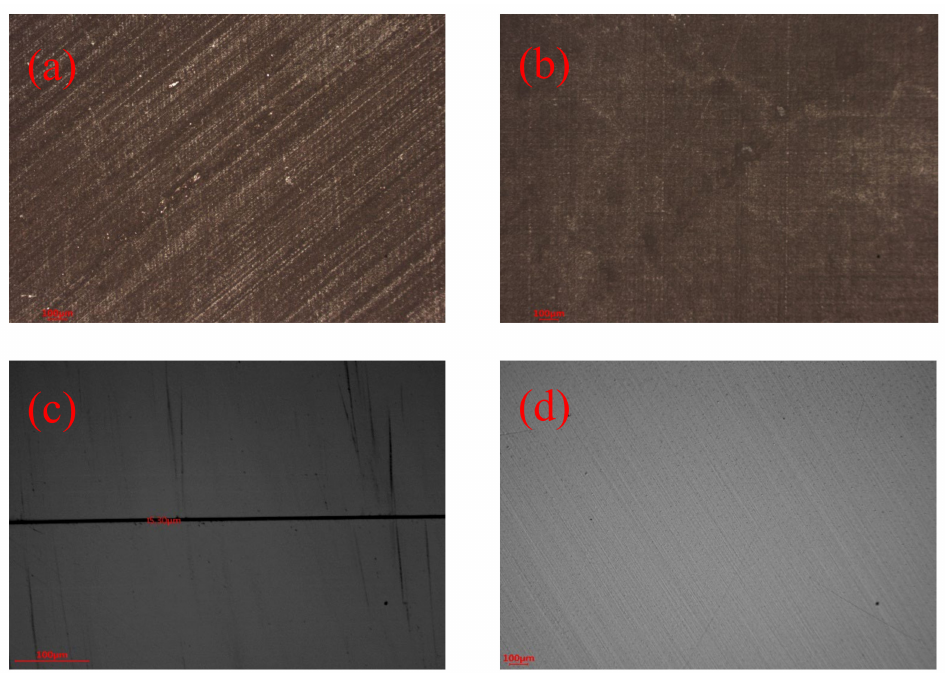
Figure 5. The laser-treated surface of the samples after different process methods. ( a ) Sample 1 with the surface after wire cutting. ( b ) Sample 2 with the surface after polishing. ( c ) Sample 3 with the surface after mechanical polishing. ( d ) Sample 4 with the surface after chemical mechanical polishing.